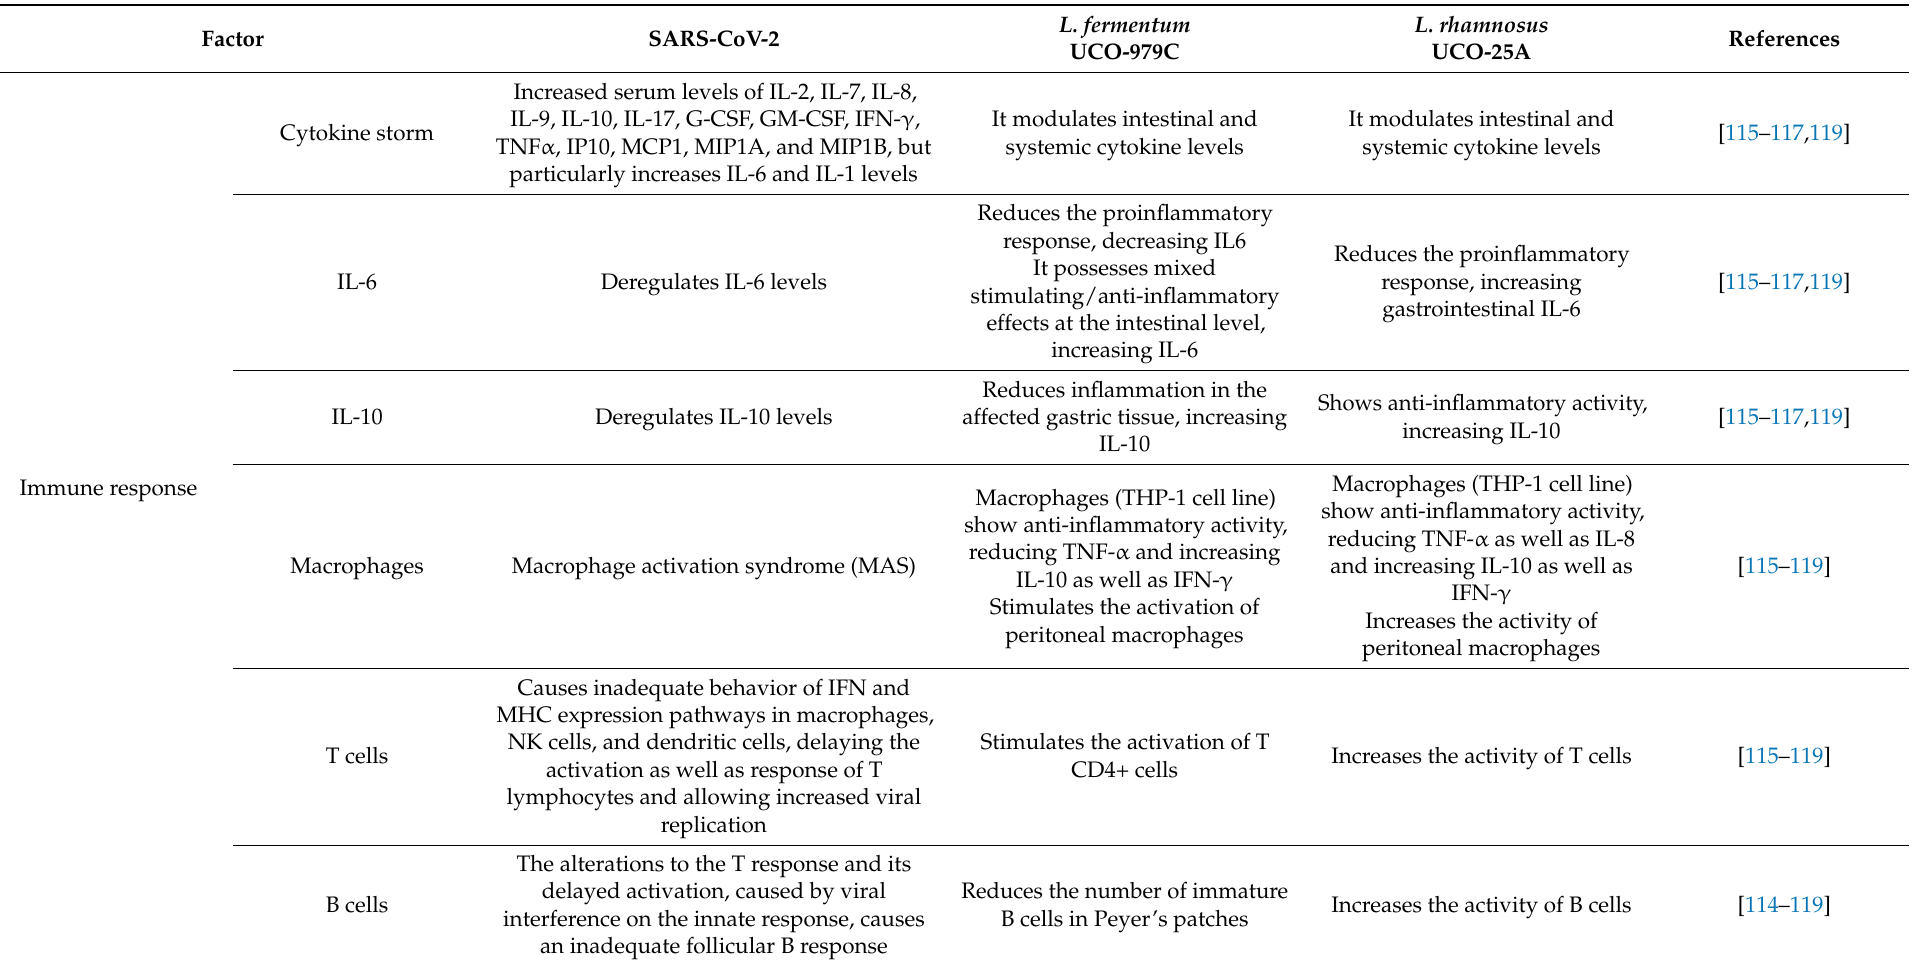
Table 2. Comparison of the effect of SARS-CoV-2, based on previous studies on Limosilactobacillus fermentum UCO-979C and Lacticaseibacillus rhamnosus UCO-25A, on the immune response and the intestinal